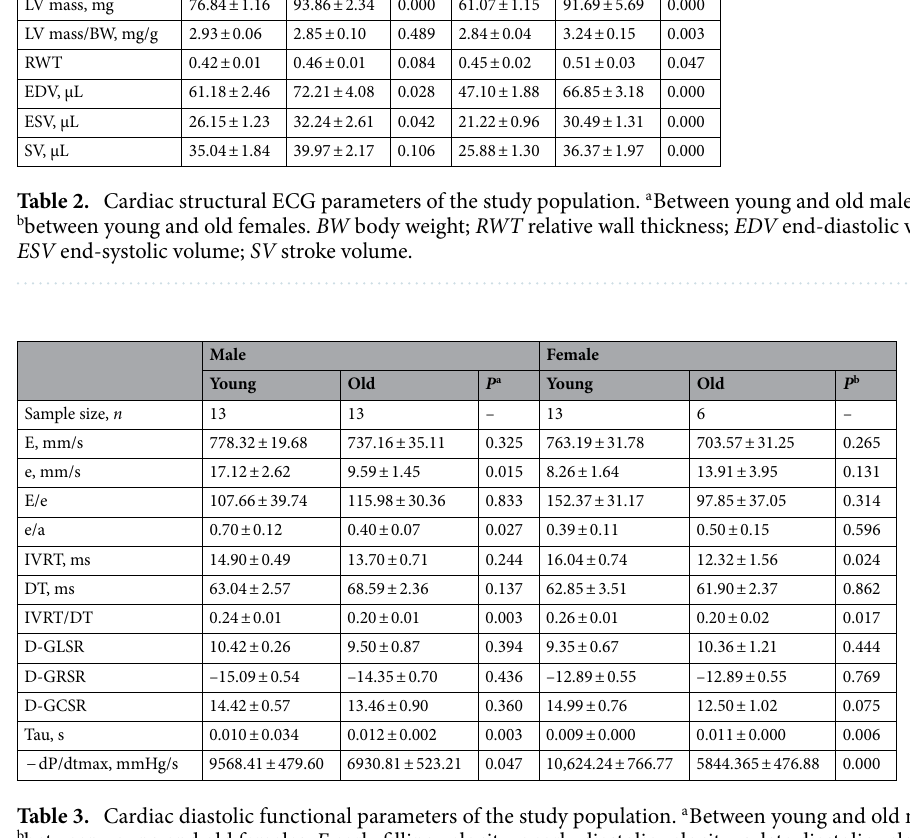
Table 3. Cardiac diastolic functional parameters of the study population. a Between young and old males; b between young and old females. E early filling velocity, e early diastolic velocity, a : late diastolic velocity, IVRT : isovolumetric relaxation time, DT diastolic time interval, D-GLSR diastolic global longitudinal strain rate, D-GRSR diastolic global radial strain rate, D-GCSR : diastolic global circumferential strain rate, Tau : LV relaxation time constant, − dp / dtmax the maximum drop rate of pressure in left